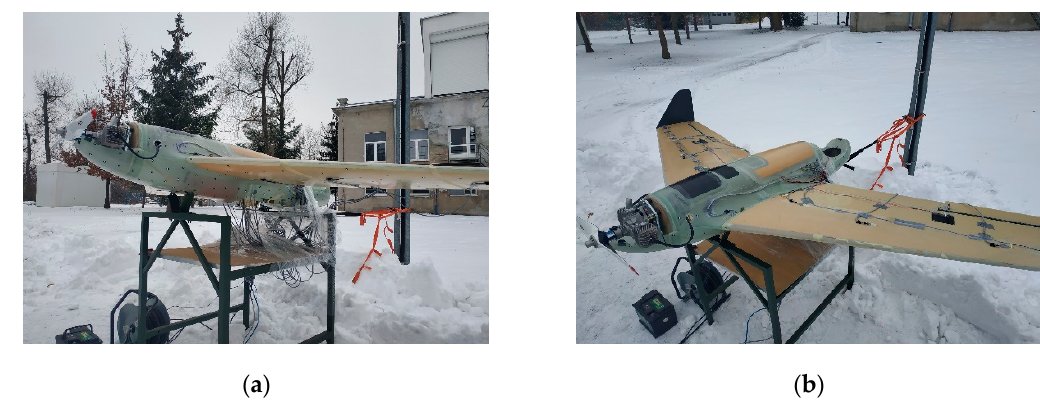
Figure 15. Hornet on the test stand for the engine test ( a ) bottom view, and ( b ) top view.